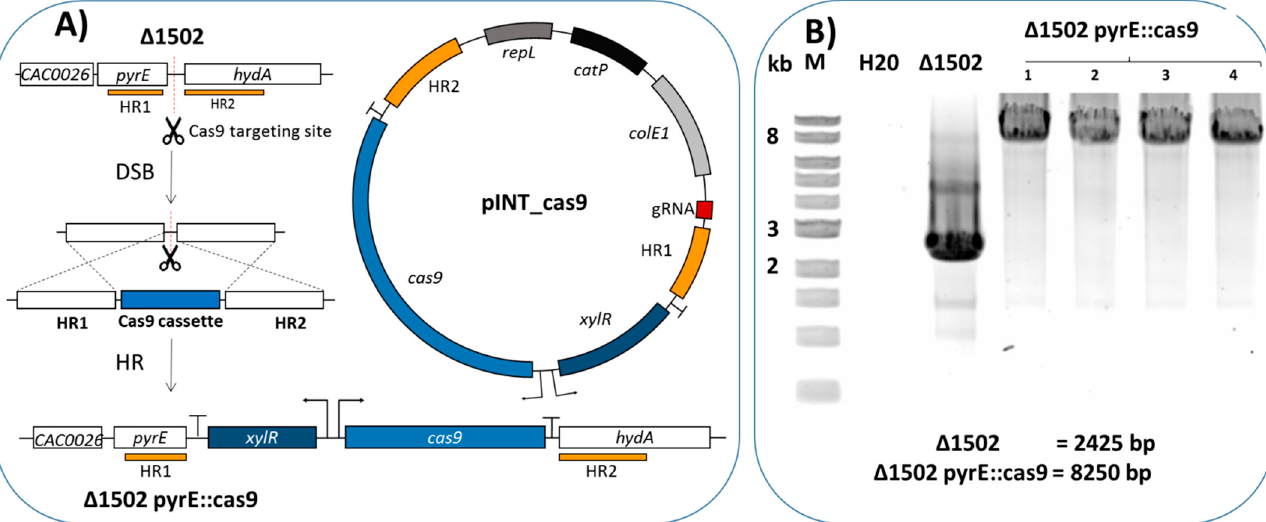
Figure 1. Integration of the Cas (clustered regularly interspaced short palindromic repeats (CRISPR)-associated pro- teins)9 cassette at the pyrE locus. ( A ) Schematic representation of the process of integrating the Cas9 cassette at the pyrE locus using the pINT_Cas9 plasmid in Clostridium acetobutylicum . Cas9 in combination with the guide RNA (gRNA) caused a double-strand break at the intergenic region, selecting only cells that have undergone a spontaneous homologous recombination event, resulting in the insertion of the Cas9 cassette. ( B ) PCR amplification using primers PS1 and PS2 showing the correct integration of the Cas9 cassette at the pyrE locus, amplification results in a 2425 bp band for the wild type, and an 8250 bp band when the Cas9 cassette was integrated. Lane M, 2-log DNA ladder (NEB); H20, water control; Δ 1502, MGC Δ cac1502 gDNA; 1–4, CAS1 ( Δ cac1502, pyrE::cas9) clones 1–4.